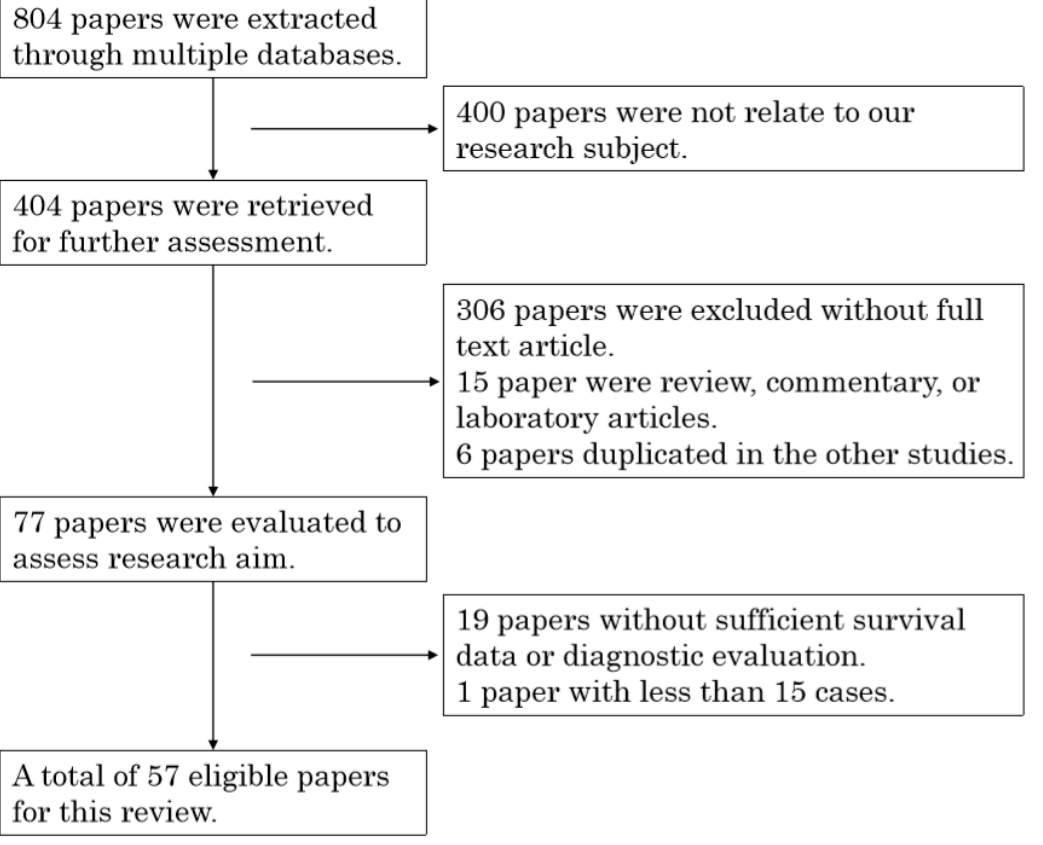
Figure 1. Selection process for literature in the meta-analysis.